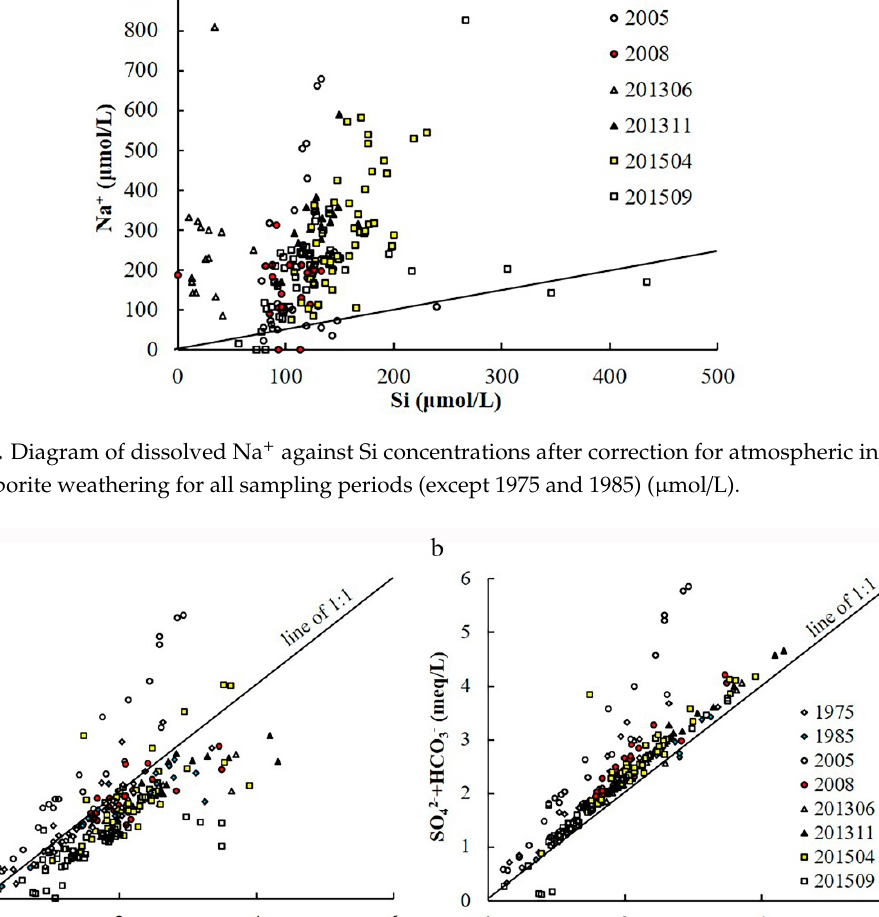
Figure 5. Diagram of dissolved Na + against Si concentrations after correction for atmospheric input and evaporite weathering for all sampling periods (except 1975 and 1985) ( μ mol/L).